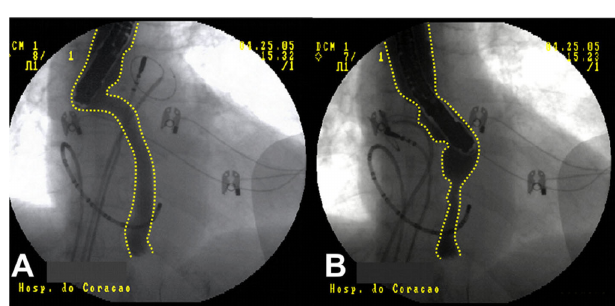
Fig. 6 - Good esophageal displacement allowing large bilateral antrum